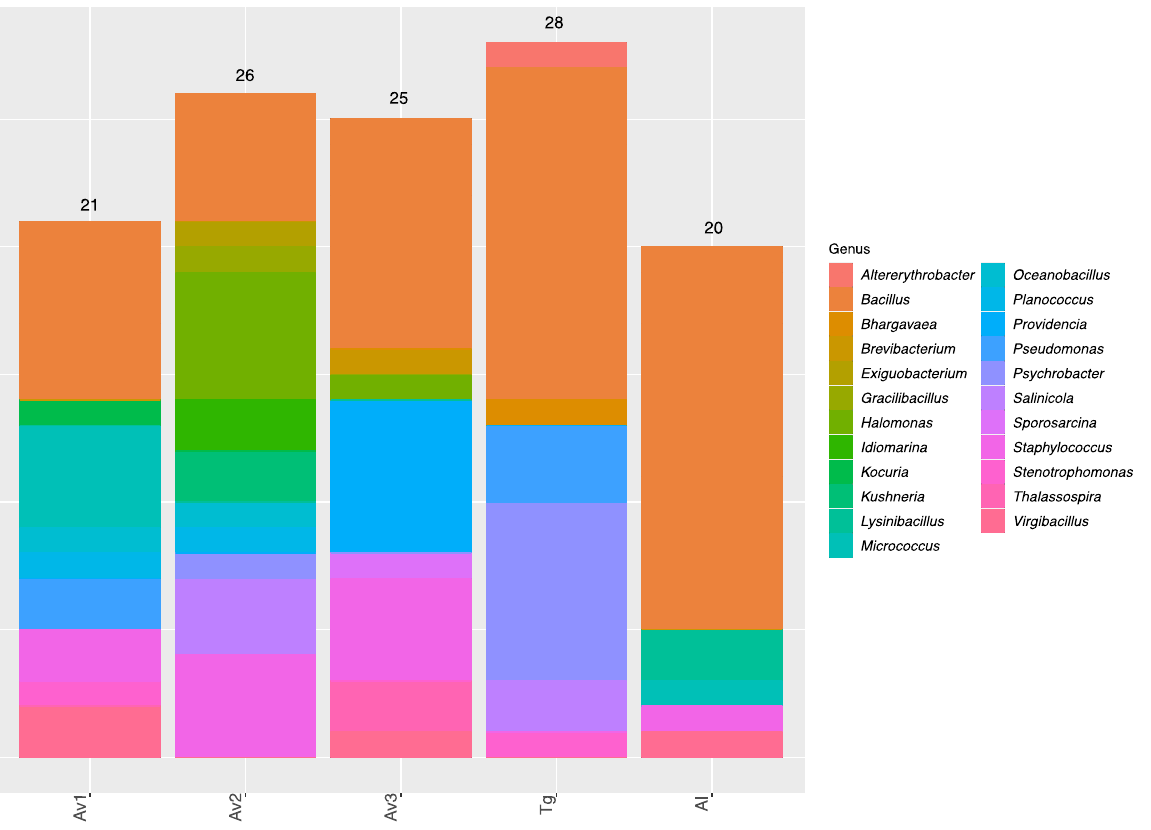
Table 1. Physico-chemical properties of sediments and pore water at Ria de Aveiro (Av), Tagus estuary (Tg) and Almargem (Al) saltmarshes.